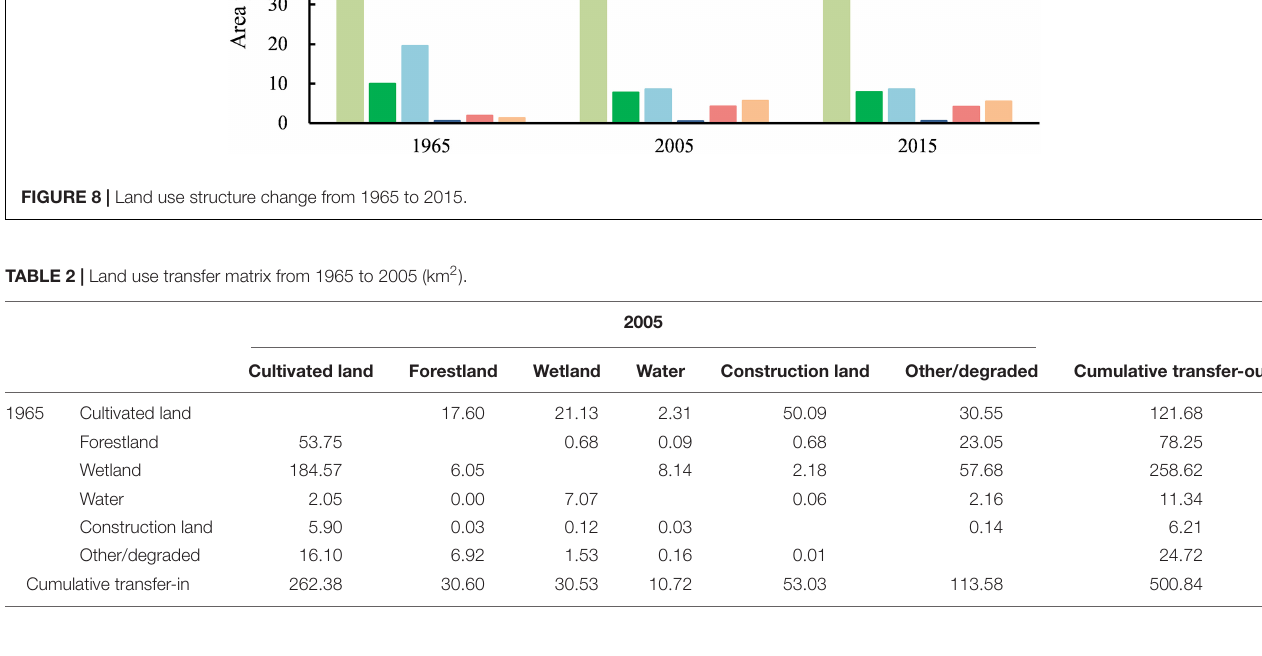
TABLE 3 | Land use transfer matrix from 2005 to 2015 (km 2 ).